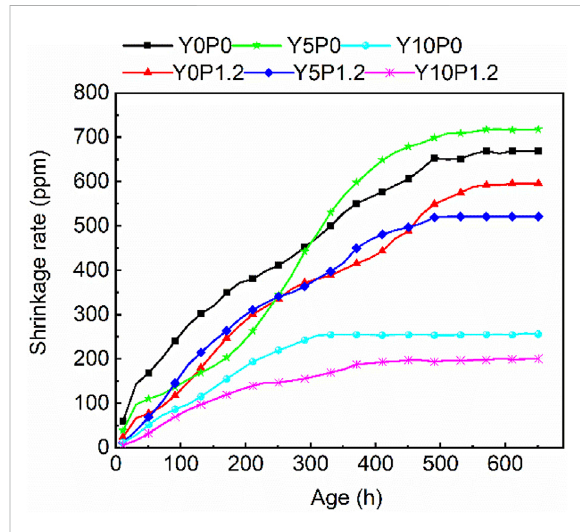
FIGURE 6 Development curve of autogenous shrinkage rate with